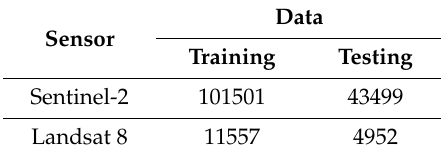
Table A1. Satellite images used in the study.